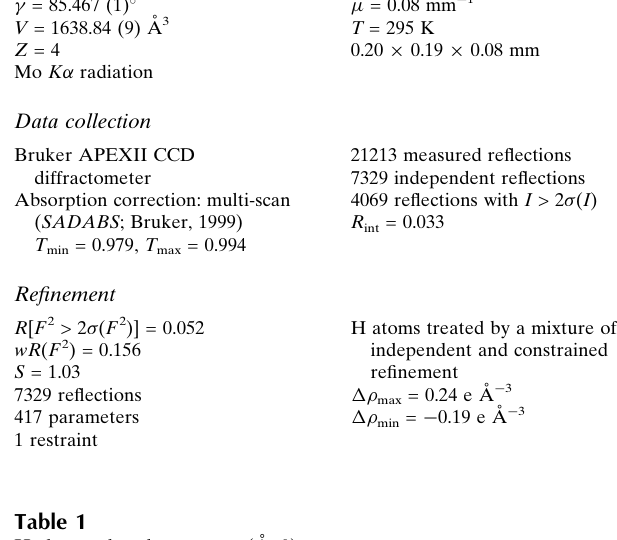
Hydrogen-bond geometry (A˚ , (cid:2)